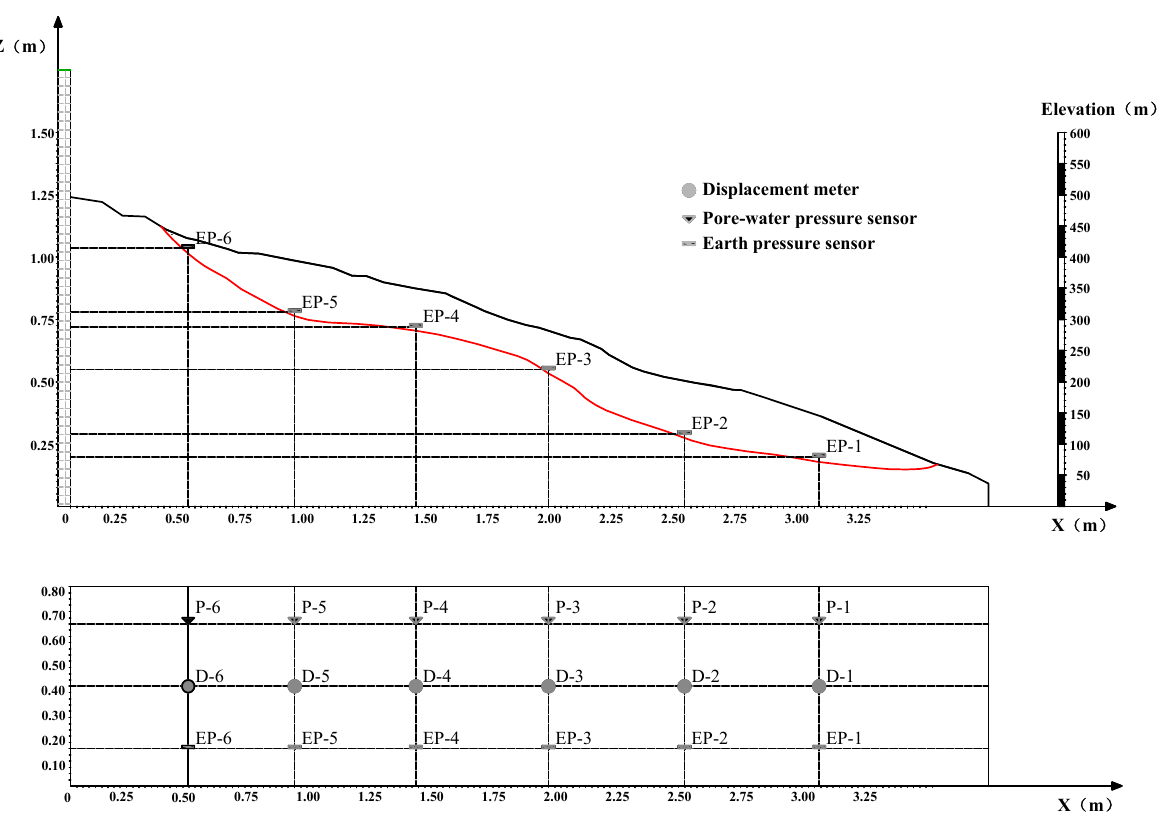
Figure 6. Monitoring layout of the test models. Table 2. Instrumentation installed in the slope